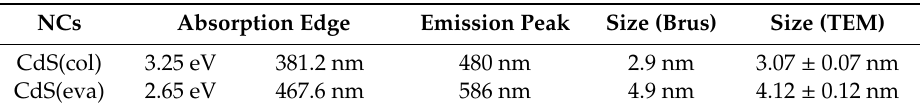
Table 1. Comparison between colloidal CdS nanoparticles and evaporated CdS nanoparticles powder. Absorption edge values, wavelength of the maximum emission peak, diameter of the nanoparticles calculated by the Brus equation and measured from TEM images.